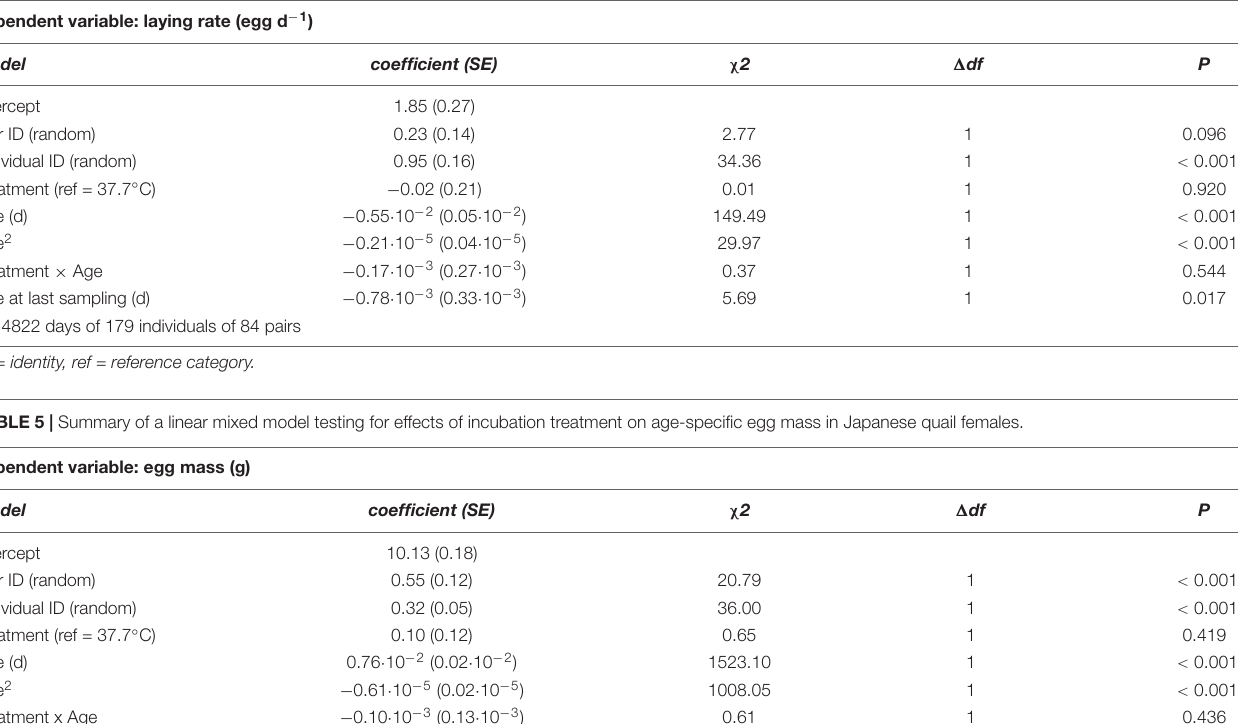
TABLE 4 | Summary of a generalized linear mixed model testing for effects of incubation treatment on age-specific laying rate in Japanese quail females.